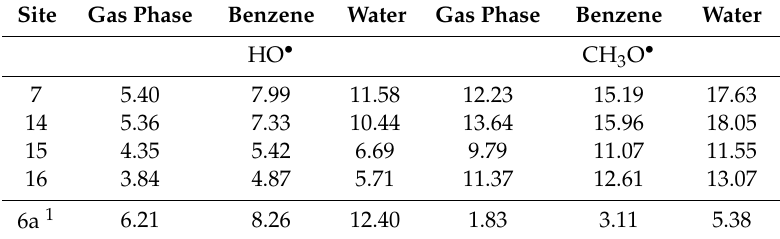
Table 2. ∆ G ‡ HAT (kcal mol − 1 ) in the gas phase, benzene, and water, for the scavenging of HO • and CH 3 O • through HAT in M1 and M2 . Level of theory: (SMD)-M06-2X / 6-311 + G(d,p) // M06-2X / 6-31G(d).